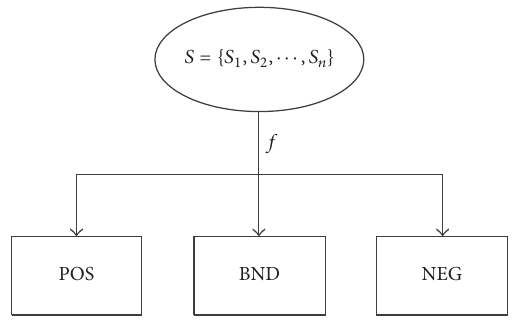
Figure 5: Three-way decisions